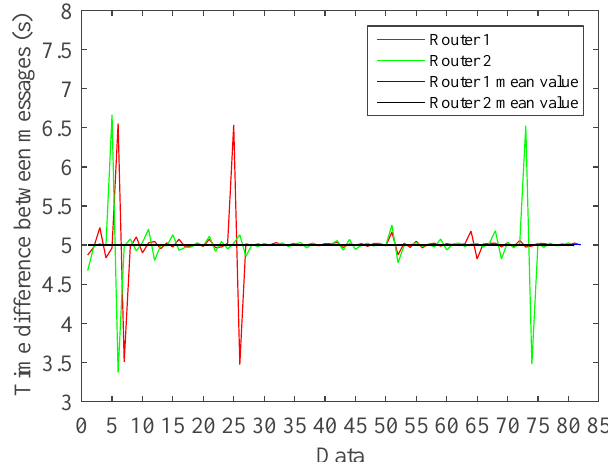
Figure 18. Case A.4: Time intervals between the data points received.